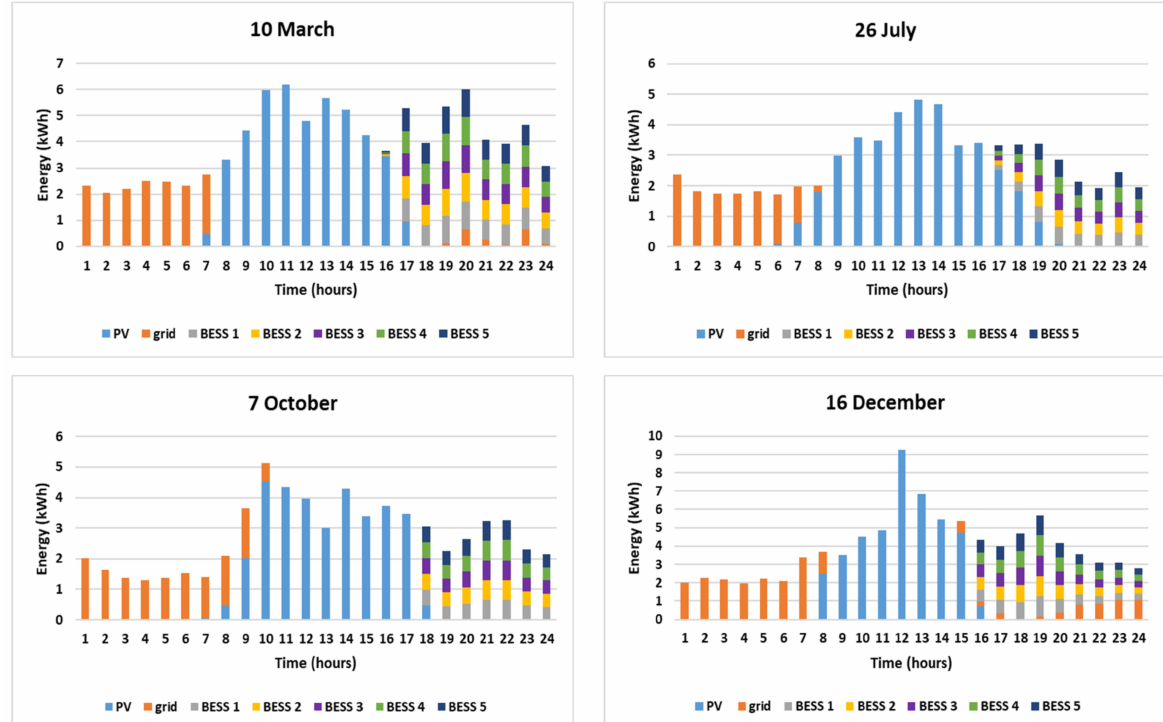
Figure 6. Energy mix of each simulated